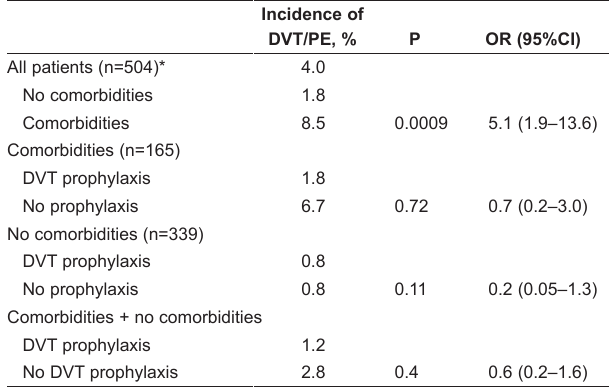
TABLE 5 Incidence of thromboembolic disease (deep